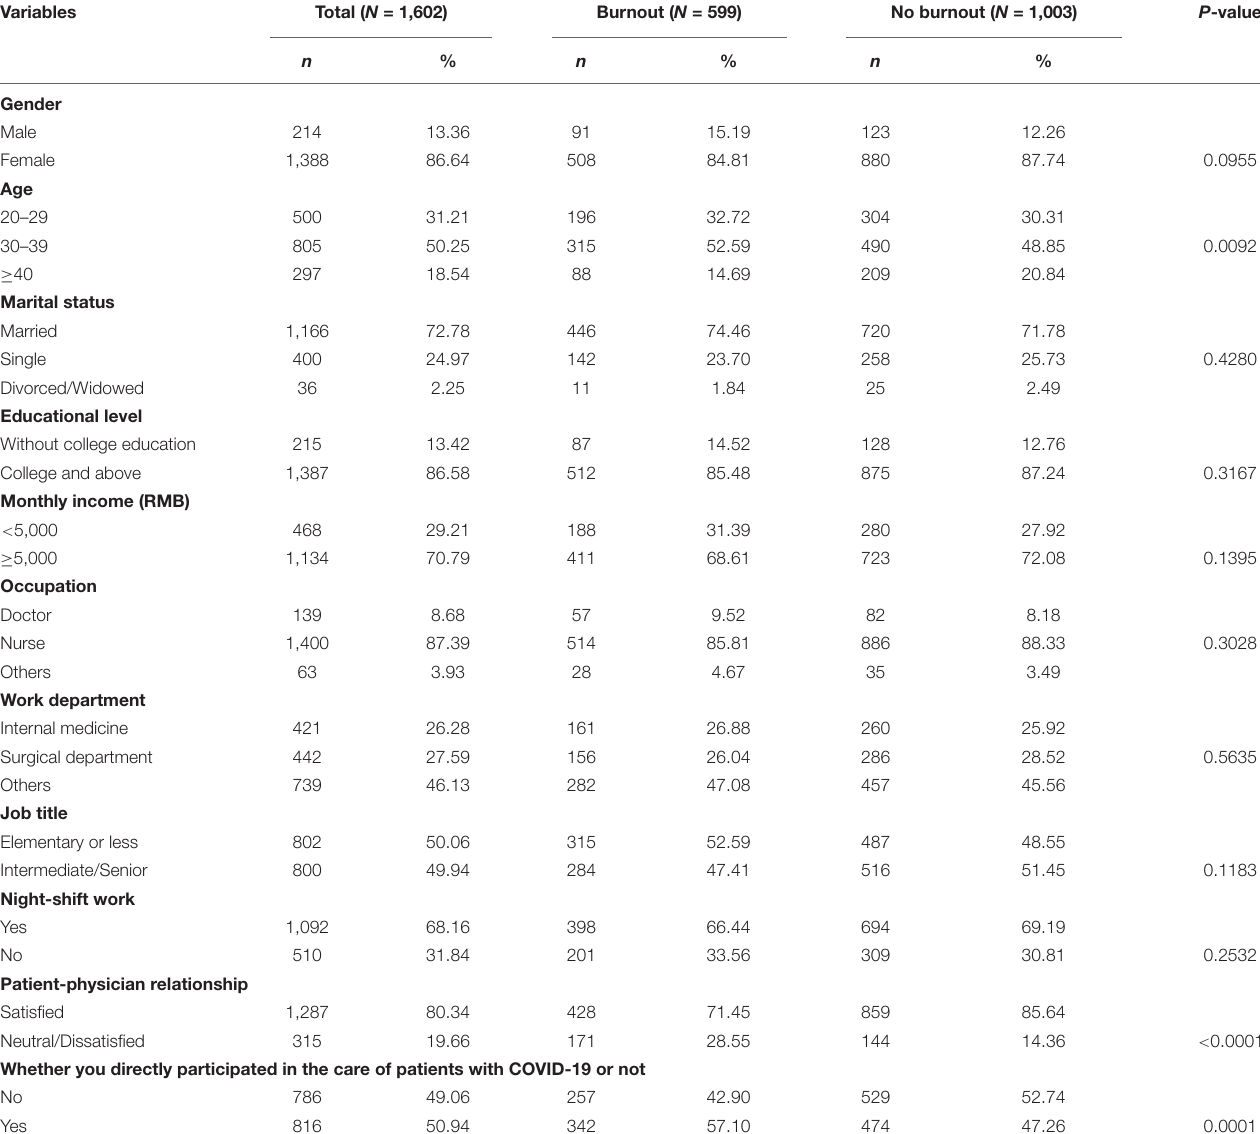
TABLE 1 | Participants’ characteristics and associations with job burnout in medical